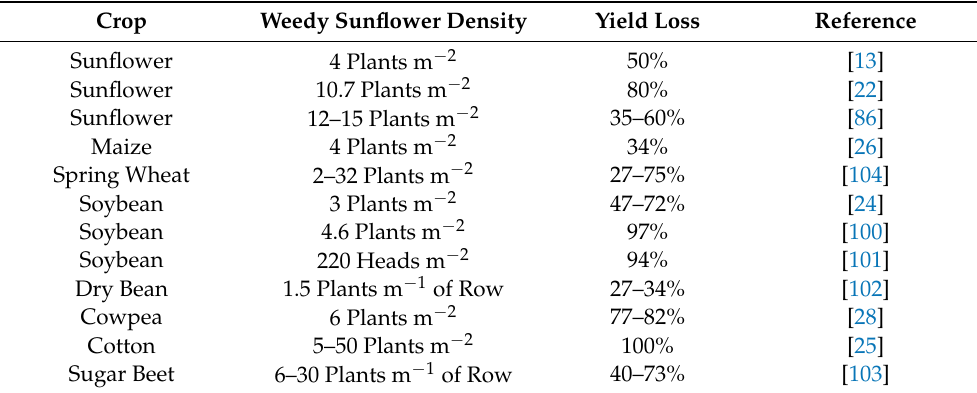
Table 3. Yield losses of summer field crops due to weedy sunflower ( Helianthus annuus L.) interference. Results presented are from field trials repeated in time or